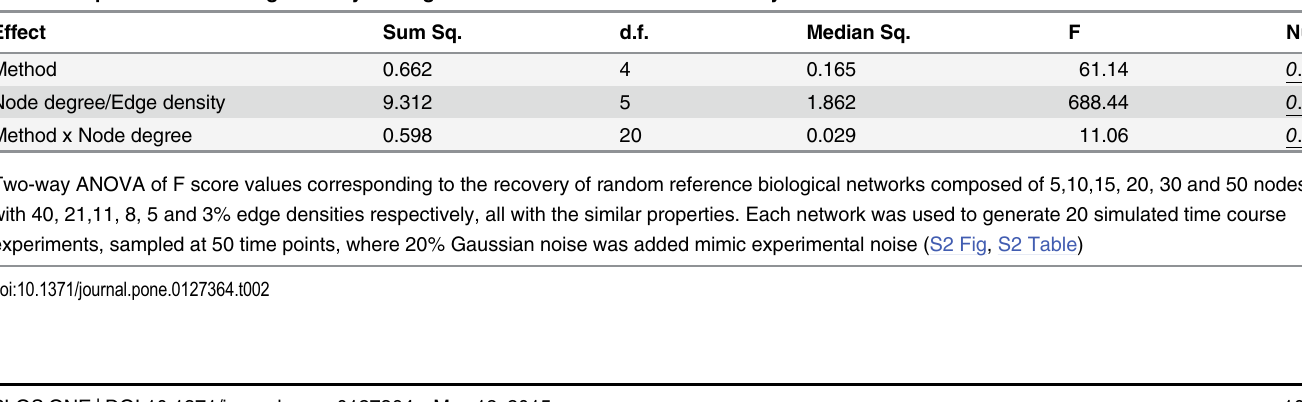
Table 2. Impact of network edge density and algorithm selection on network